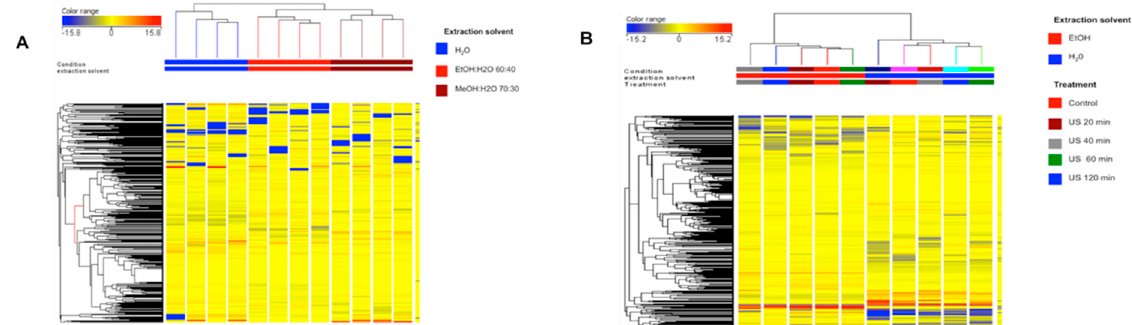
Figure 8. Non-averaged unsupervised cluster analysis on the phenolic profile of different lentil seed coat extractions, as a function of the solvent used ( A ) and solvent-extraction technique used ( B ). The compound’s intensity was used to build up the heat map, on the basis of which the clusters were generated.